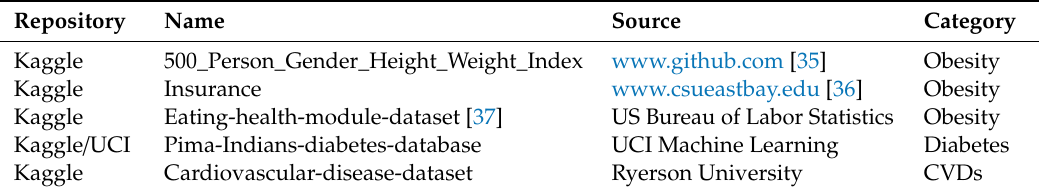
Table 3. Selected datasets for the statistical analysis and machine